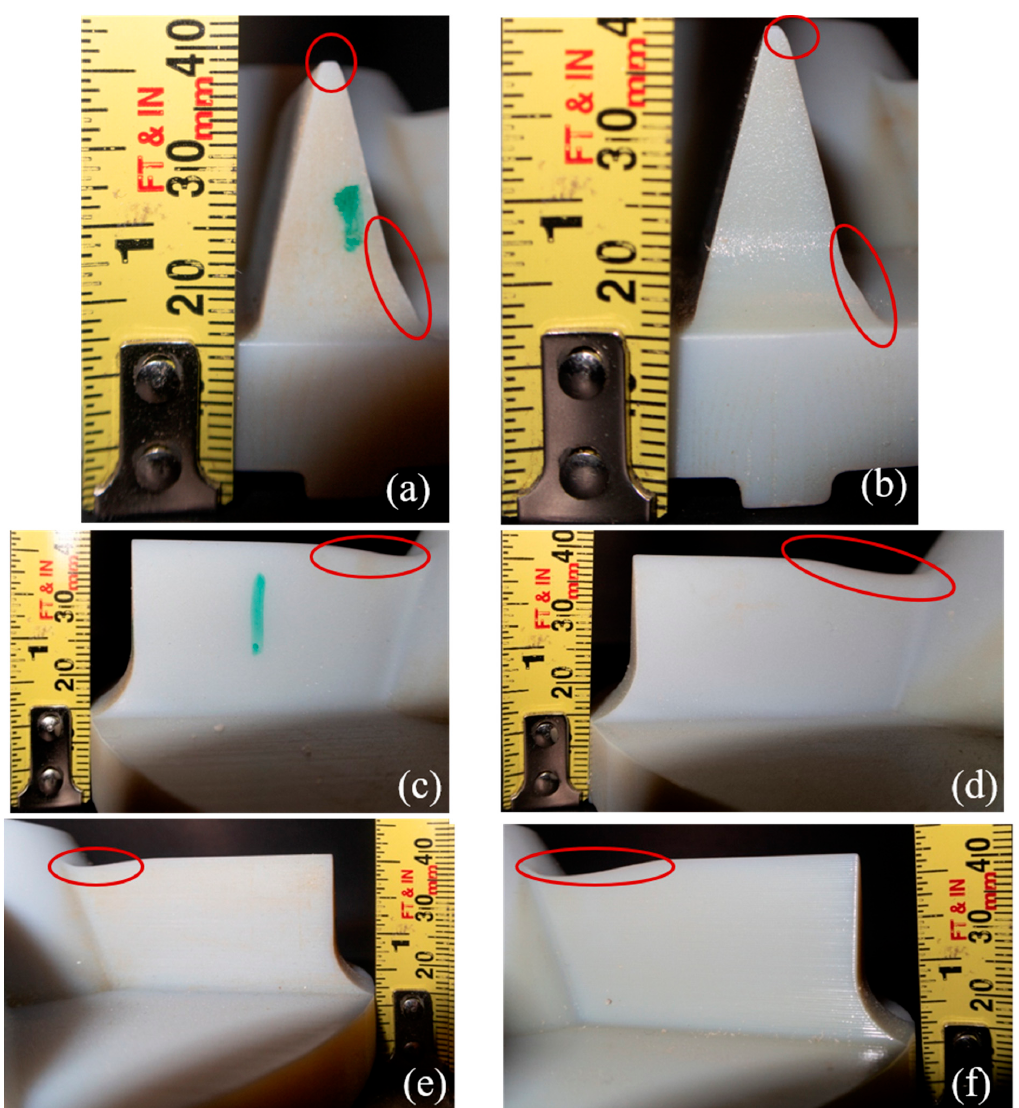
Figure 6. Wear patterns after different solids concentration with 1200 rpm and 24 h: ( a ) 5 g / g (5 mass%), wornsurfaceattheendofblades; ( b )10g / g(10mass%), wornsurfaceattheendofblades; ( c )5 g / g (5 mass%), worn surface at suction side; ( d ) 10 g / g (10 mass%), worn surface at suction side; ( e ) 5 g / g (5 mass%), worn surface at pressure side; ( f ) 10 g / g (10 mass%), worn surface at pressure